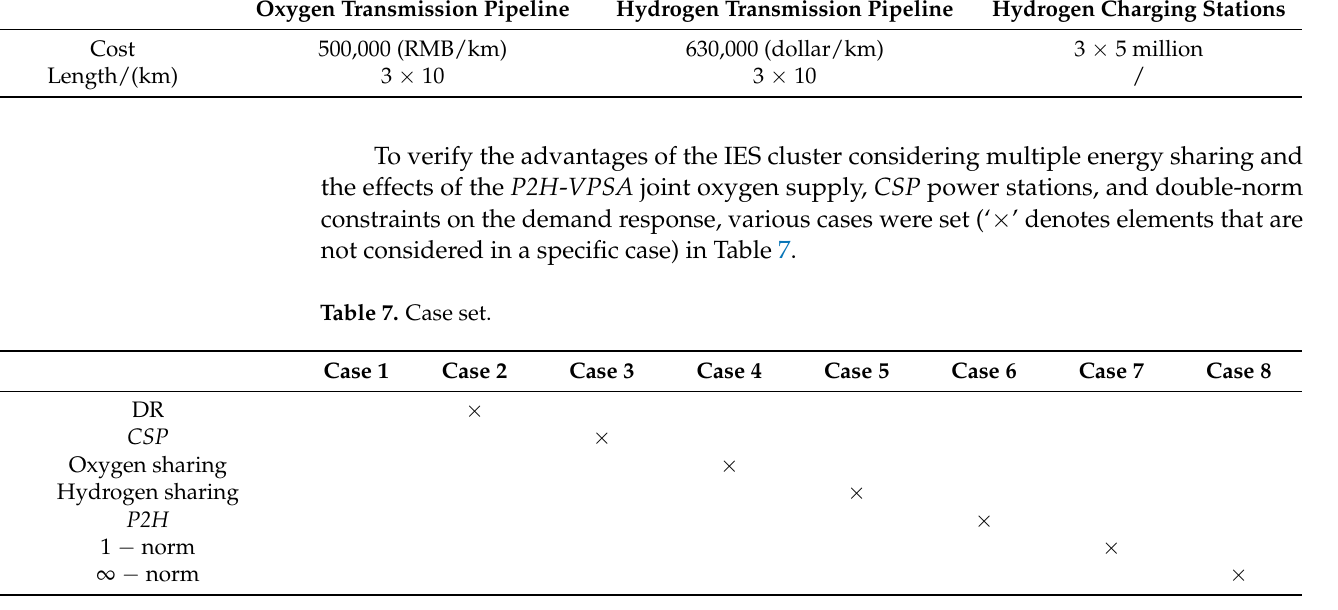
Table 6. The default laying length of each IES pipeline was 10 km.